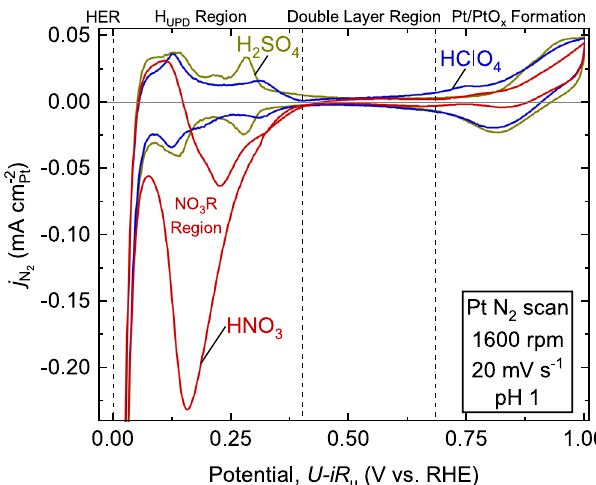
Fig. 1 Characteristic Pt cyclic voltammogram in N 2 -saturated HClO 4 , H 2 SO 4 , and HNO 3 . Representative cyclic voltammogram (CV) of the Pt disk at 20 mV s – 1 in N 2 -sat ’ ed HClO 4 , H 2 SO 4 , and HNO 3 . Dashed regions indicate approximate divisions of potential ranges as indicated along the top: hydrogen evolution reaction (HER) region, hydrogen under-potential deposition (H UPD ) region, double layer capacitance region, and surface Pt oxidation/PtO x reduction region. Color code: HClO 4 (blue), HNO 3 (red), and H 2 SO 4